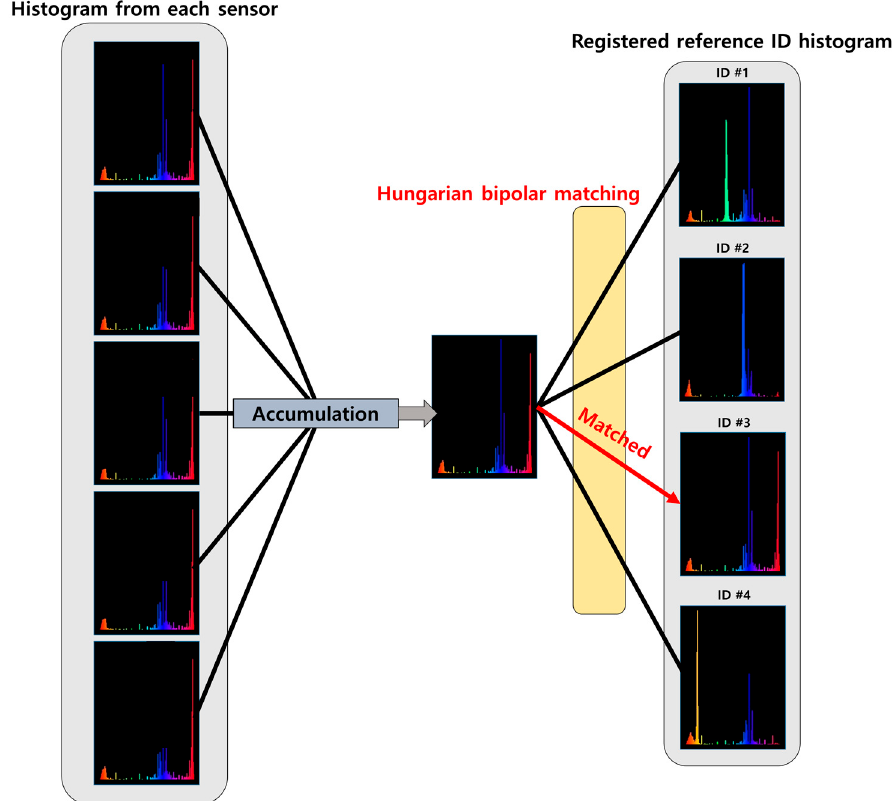
Figure 5. The procedure of ID assignment based on hue value histogram matching.